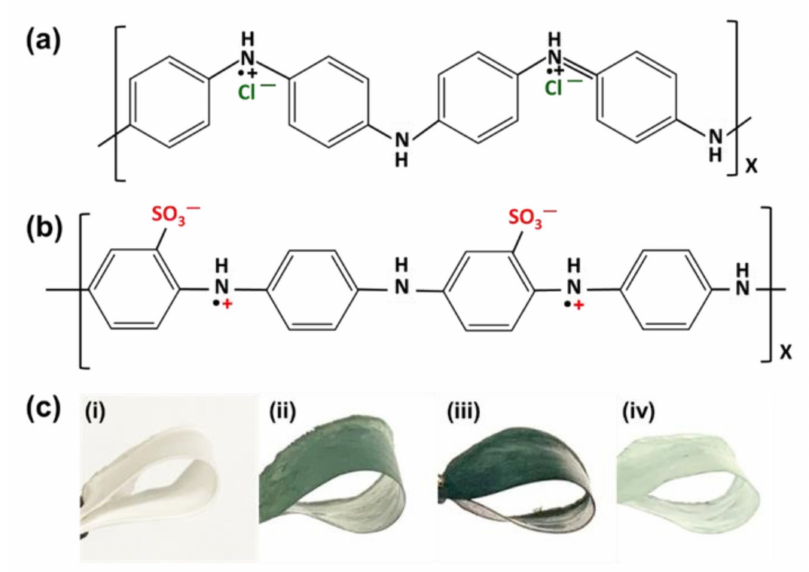
Figure 7. Chemical structure of ( a ) PANI ES in HCl, and ( b ) PANI ES in H 2 SO 4 . Doping of positive and negative charges on the backbone of the PANI chain for the fabrication of a zwitterionic surface. ( c ) Flexibility of the prepared films (i) PCL, (ii) f-PANI, (iii) HCP-PANI, and (iv)